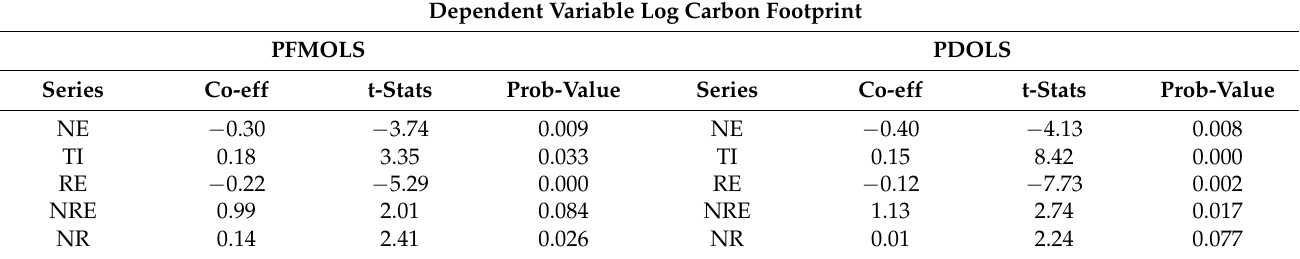
Table 7. Results of the PFMOLS and the PDOLS